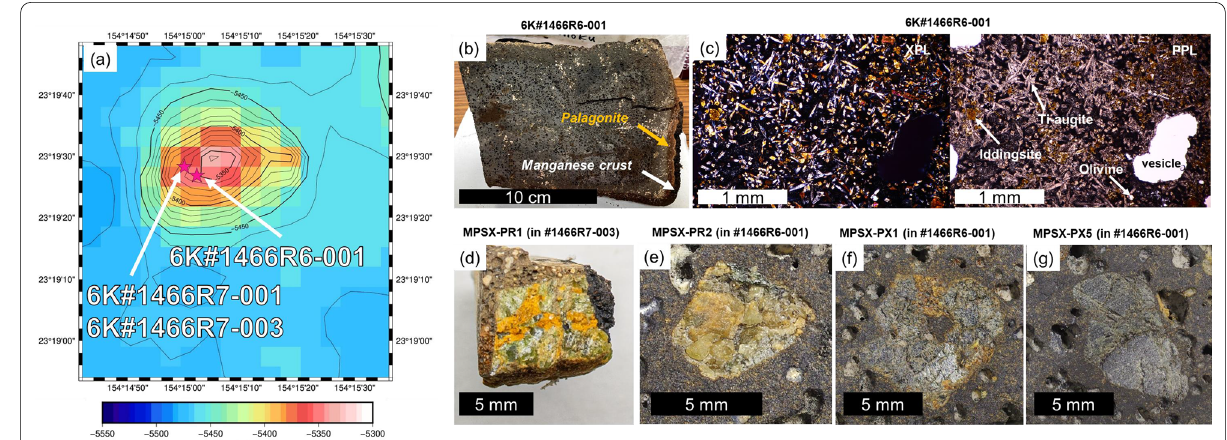
Fig. 2 Petit-spot knoll and sample descriptions. a The small conical petit-spot knoll and sampling point of the 6K#1466 dive by SHINKAI 6500 (pink stars). Three basaltic lavas, 6K#1466R6-001, R7-001, and R7-003, were collected from locations near the western slope of the knoll. b , c The representative basalt sample (6K#1466R6-001) and its photomicrograph. d – g The occurrence of ultramafic xenoliths: d MPSX-PR1, e MPSX-PR2, f MPSX-PX1, and g